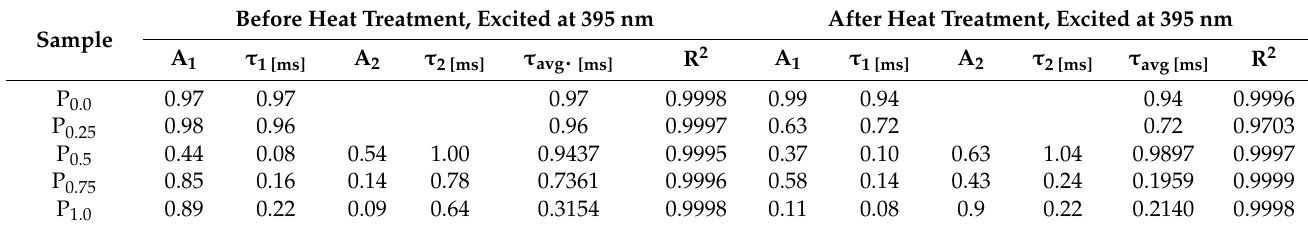
Table 4. Lifetime of 5 D 0 level at excitation of 395 nm.